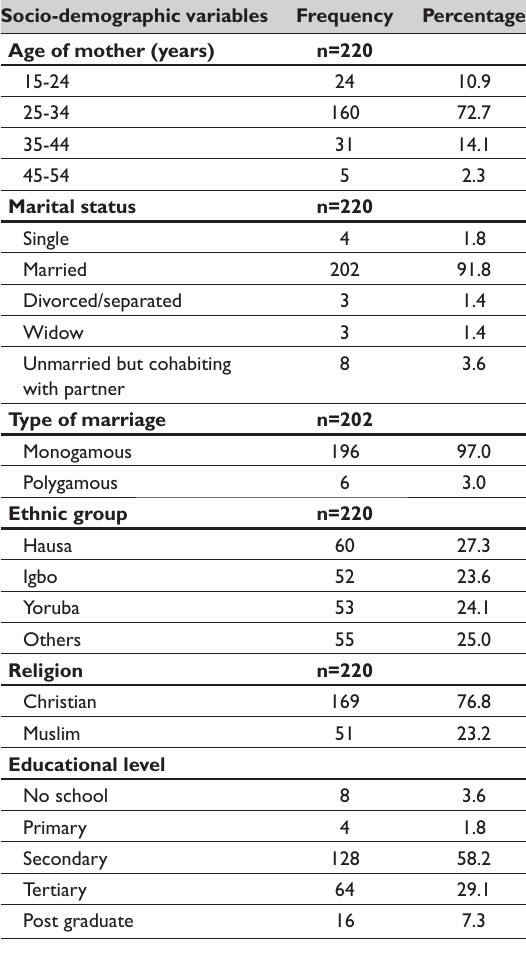
Table 1: Socio-demographic characteristics of mothers in the study Socio-demographic